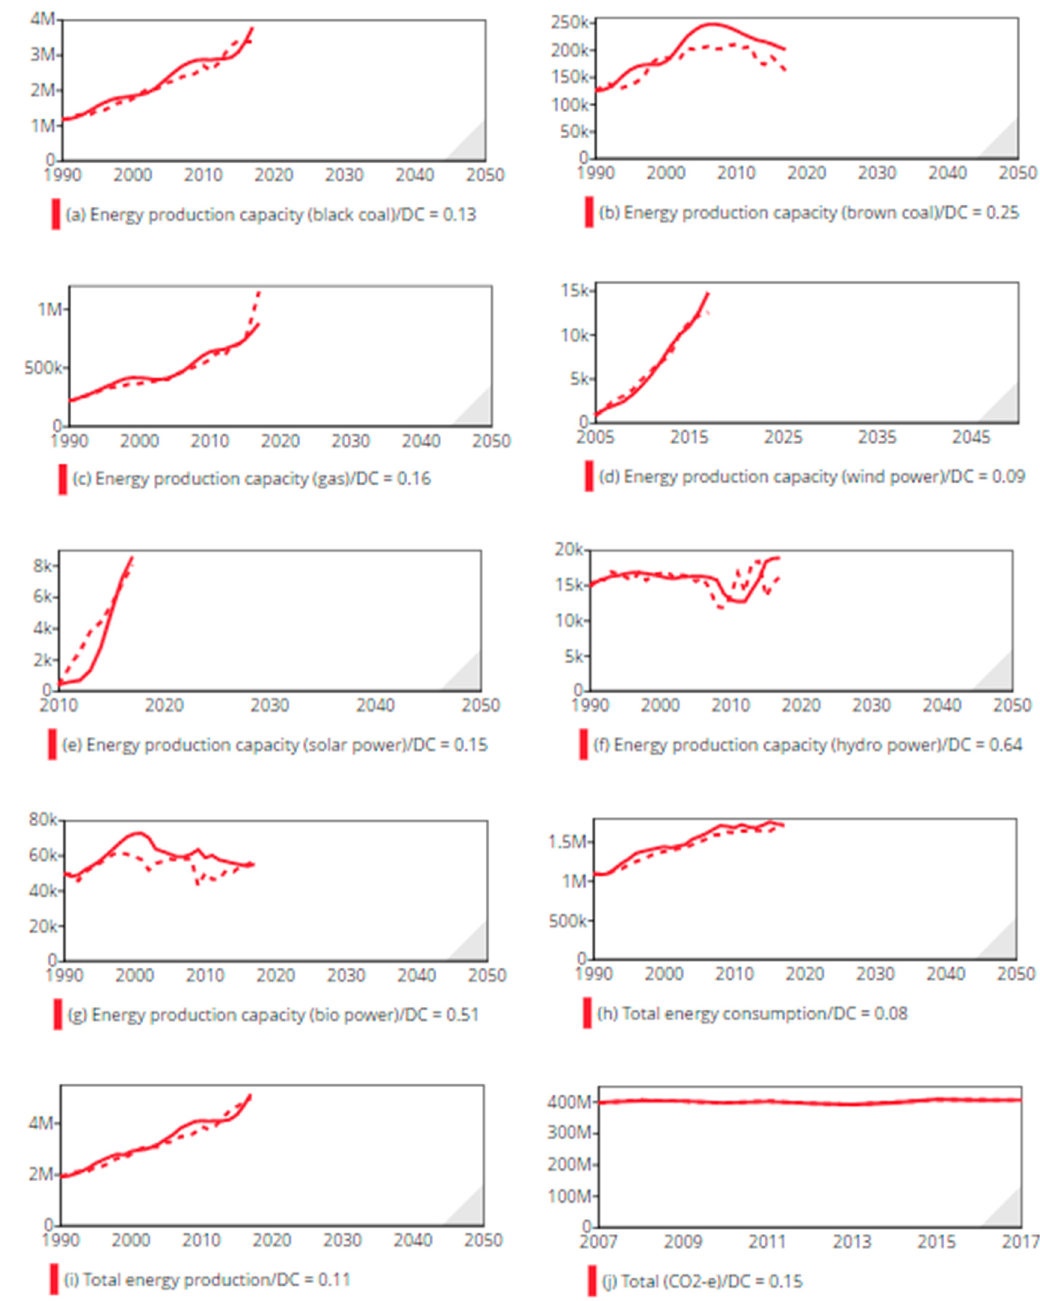
Figure 6. Comparison of real historical trends (dotted lines) and simulated trends (solid lines) for ( a ) energy production capacity of black coal, ( b ) energy production capacity of brown coal, ( c ) energy production capacity of gas, ( d ) energy production capacity of wind power, ( e ) energy production capacity of solar power, ( f ) energy production capacity of hydropower, ( g ) energy production capacity of biopower, ( h ) total energy consumption, ( i ) total energy production and ( j ) total (CO 2 -e) (ton). Production and consumption in GWh. CO 2 emissions in tons.